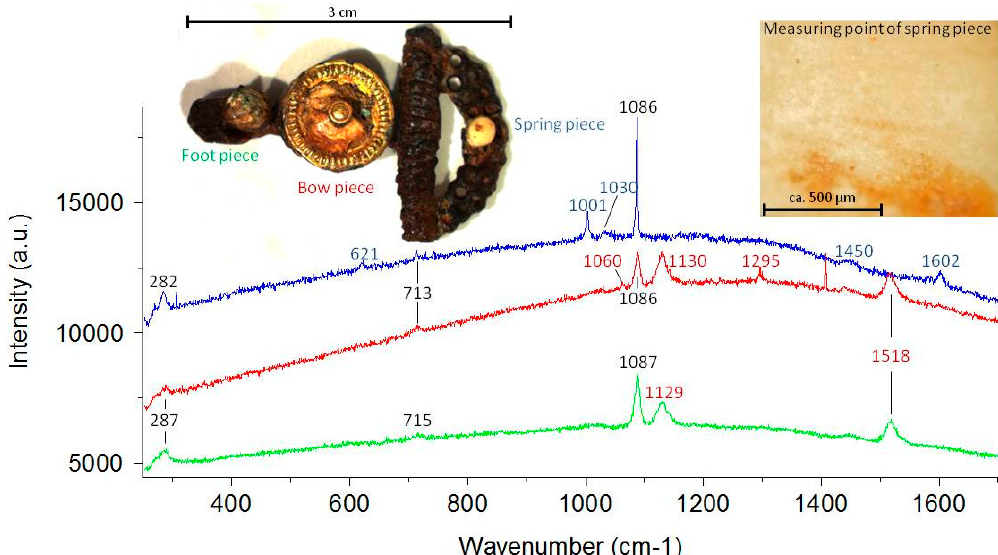
Figure 5. Raman spectra of the three light colored pieces of the fibula from Schwieberdingen “Wartbiegel”, taken with 632.8 nm. The pieces from the foot (green) and from the bow (red) of the fibula clearly show calcite and polyene features, indicating C. rubrum . In contrast, the piece from the spring of the fibula (blue) yields a spectrum with a sharp CaCO 3 band at 1086 cm − 1 , but no pigment bands.